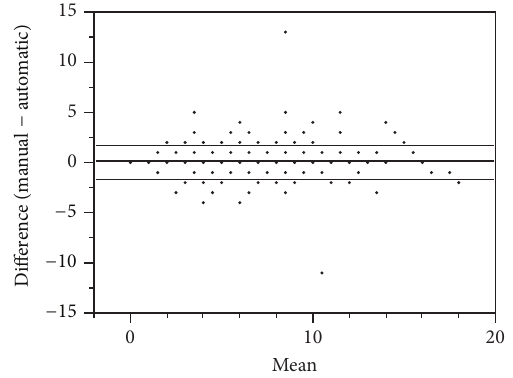
Figure 2: Validation cohort: Bland-Altman plot of the manual versus automatic scores resulted in a mean difference of 0.12 ± 1.64 (SD, 𝑁 = 268 ). Note: plotted values frequently represent more than one patient